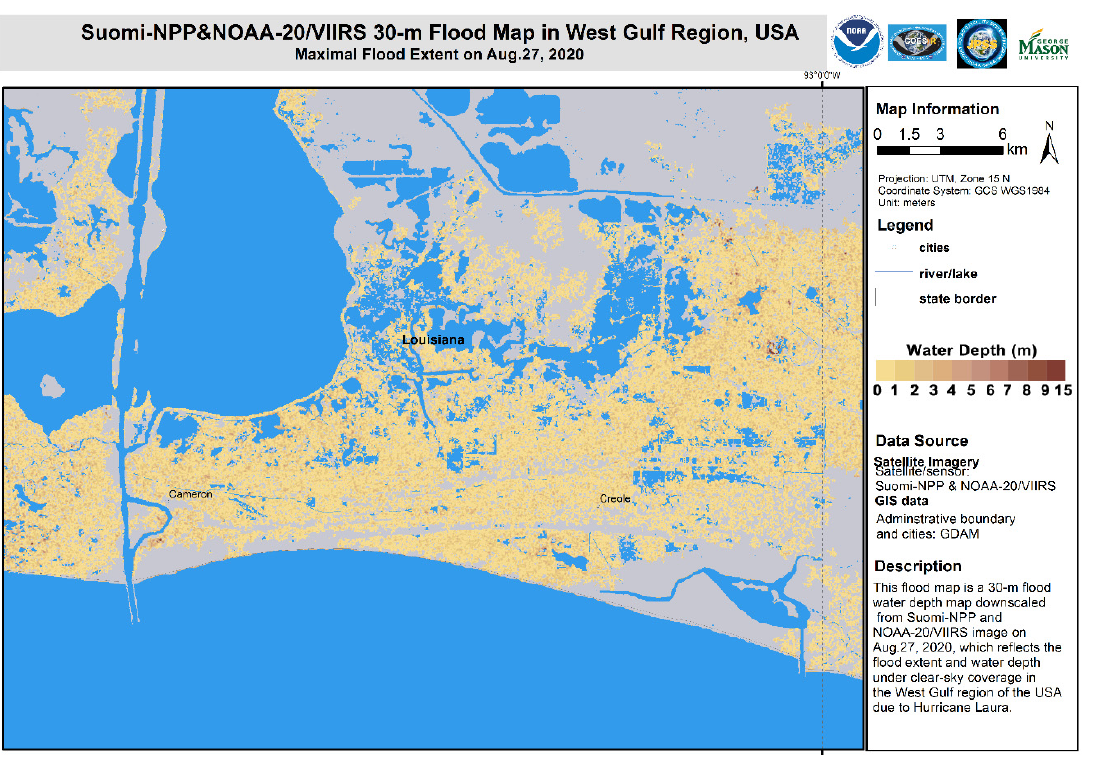
Figure 7. VIIRS downscaled 30 m floodwater depths in the West Gulf region due to Hurricane Laura